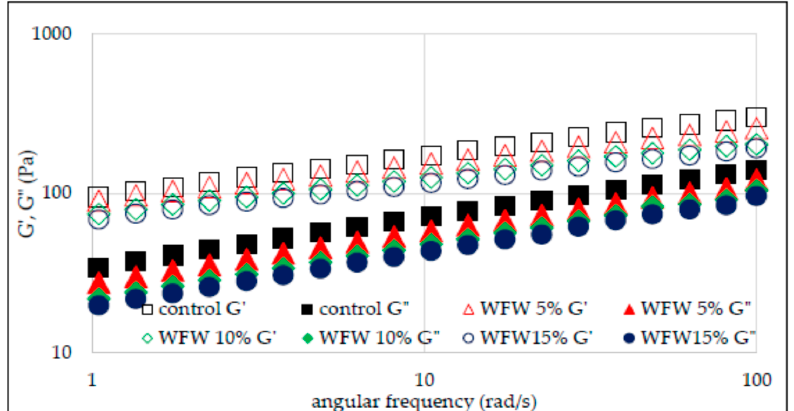
Figure 4. Sweep frequency curves of wheat flour gel and samples with walnuts addition.